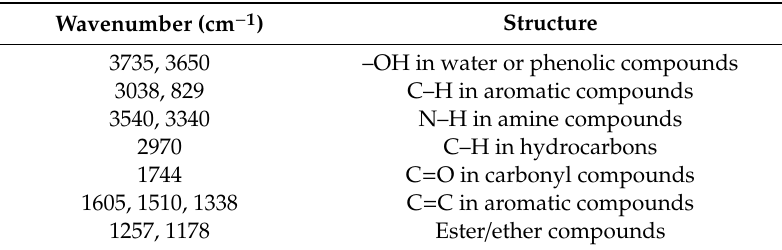
Figure 11. FTIR spectra of the pyrolysis products of the EP control and EP / PIPC-5 at 350, T max , 500, 600 ◦ C. Table 4. Infrared characteristic peak of the main pyrolysis product